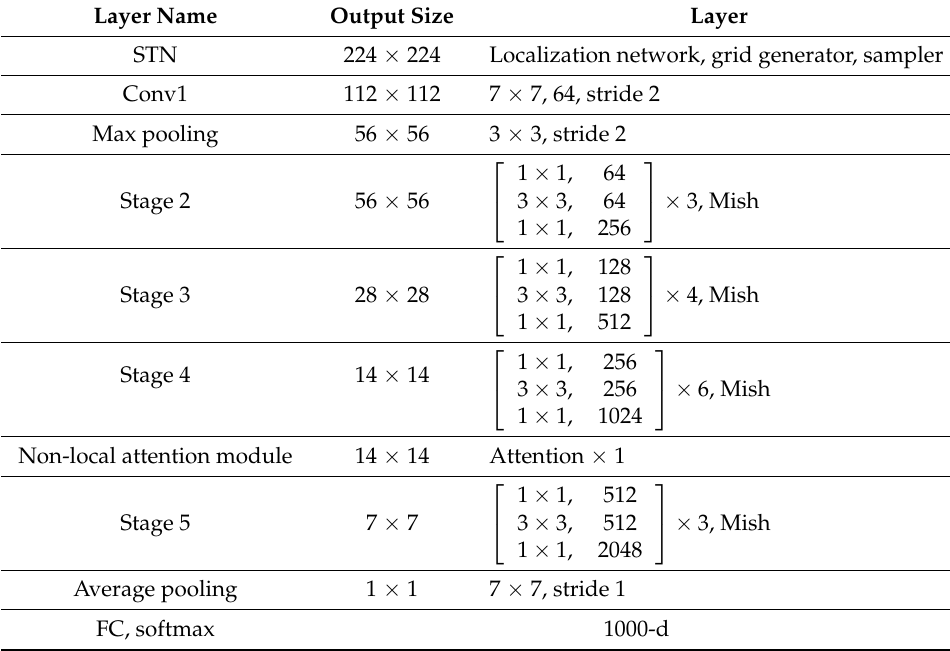
Table 2. The architecture of the proposed method.